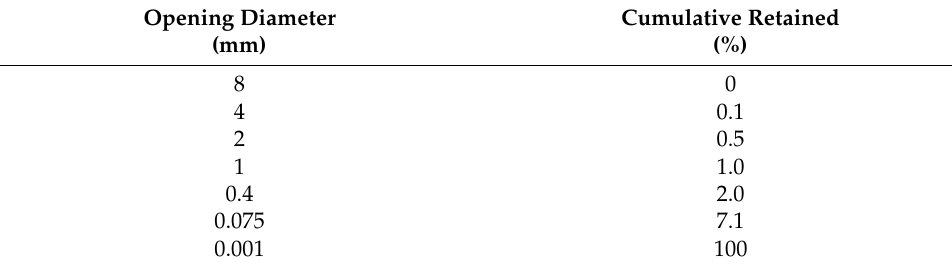
Table 2. Sieve analysis of the soil sample collected on site (EN